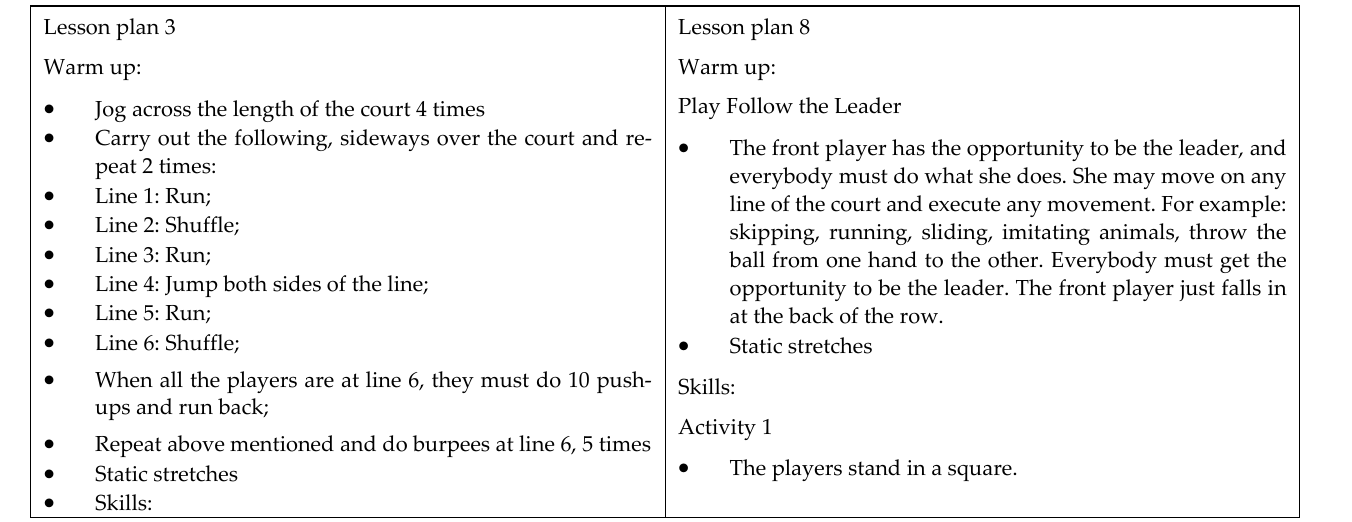
Table A1. Example of two sports vision lessons (progression).